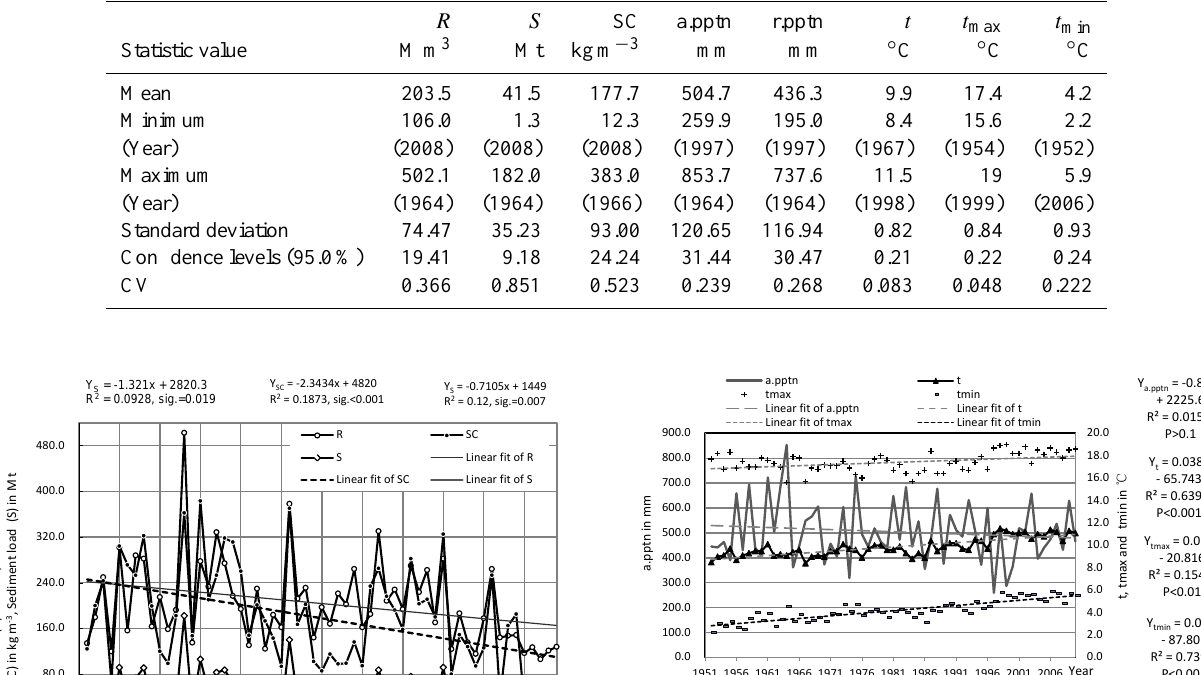
Table 1. Statistics for runoff ( R ), sediment concentration (SC), sediment load ( S ), precipitation (pptn), and temperature ( t , t max and t min ) of the Yan River in 1952–2010.